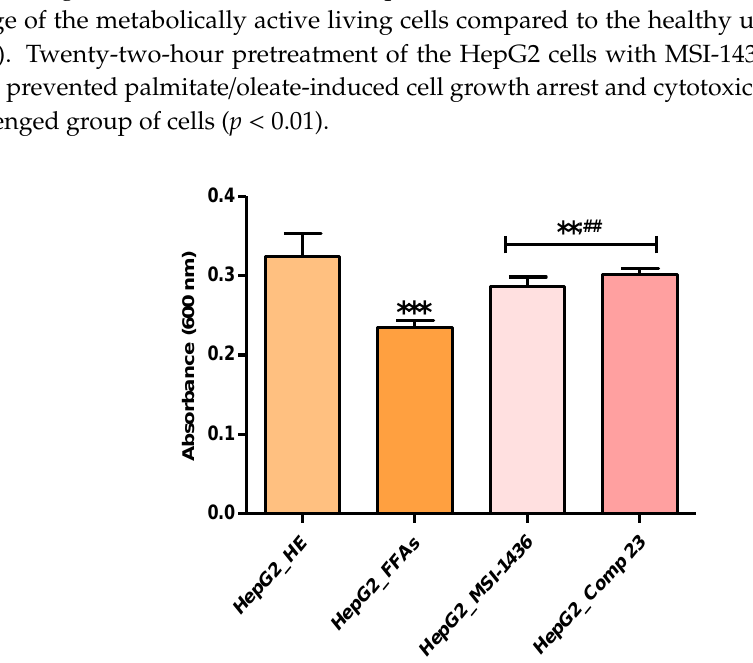
Figure 1. Cytotoxicity in HepG2 cells upon exposure to the palmitate/oleate combination and protein–tyrosine phosphatases (PTP) inhibitor pre-conditioning. Histograms represent the average absorbance of the metabolized resazurin dye at 600 nm after cell exposure. The results are expressed as the mean of 3 different experiments ± SD. Asterisks (*) refer to a comparison of all treated groups to untreated healthy cells. A hashtag (#) refers to a comparison between PTP inhibitor treated groups and FFA-challenged cells. **/##, p < 0.01, ***, p < 0.001. HepG2_HE: HepG2 healthy untreated cells; HepG2_FFAs: HepG2 cells exposed to the palmitate/oleate combination; HepG2_MSI-1436: HepG2 cells pre-treated with 1 µM MSI-1436 inhibitor and exposed to the palmitate/oleate combination; HepG2_Comp 23: HepG2 cells pretreated with 1 µ M compound 23 inhibitor and exposed to